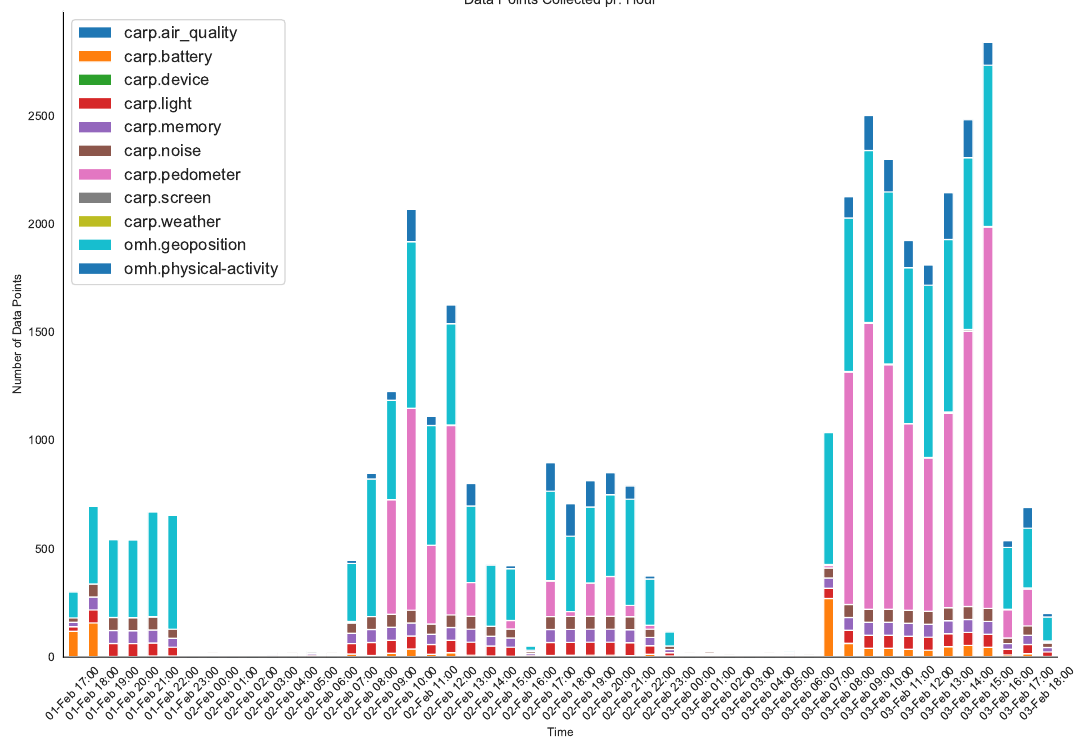
Figure 8. Data collection using the context, device, and sensor sampling packages. Hourly count of each data type in zulu (GMT)